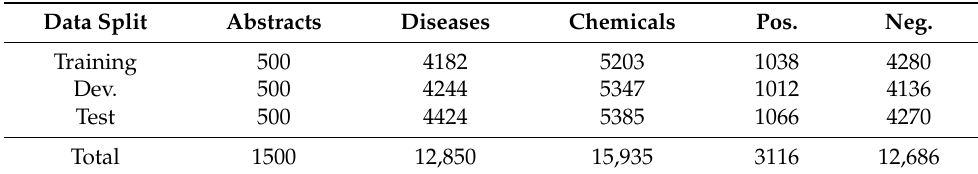
Table 1. Stats for the CDR dataset.